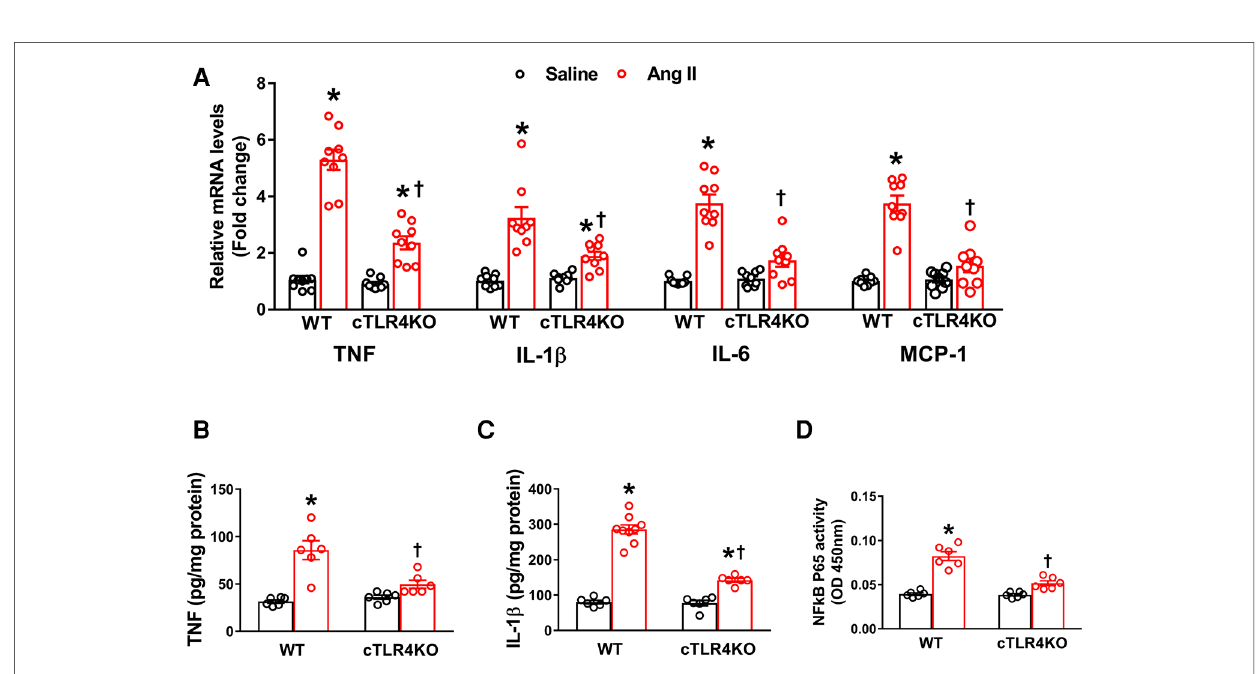
FIGURE 6 Cardiomyocyte-speci fi c TLR4 knockdown reduces mRNA expression of pro-in fl ammatory markers. ( A ) Angiotensin II (Ang II) infusion for 2 weeks signi fi cantly increased TNF, IL-1 β , IL-6, and MCP-1 mRNA expression in the left ventricle cardiac tissue indicating an increased in fl ammatory state. This effect was attenuated in cTLR4KO mice ( n =9, two-way ANOVA, * p <0.05 vs. WT+Saline, † p <0.05 vs. WT+Ang II). ELISA analysis of left ventricular lysates showed that Ang II increased ( B ) TNF and ( C ) IL-1 β in WT mice but these increases were blunted in cTLR4KO mice ( n =6 – 9, two- way ANOVA, * p <0.05 vs. WT+Saline, † p <0.05 vs. WT+Ang II). ( D ) NF- κ B binding activity measured in the left ventricle nuclear extracts exhibited a signi fi cantly increased cardiac NF- κ B p65 activity in WT mice but not in cTLR4KO mice with Ang II-infusion ( n =6, two-way ANOVA, * p <0.05 vs. WT +Saline, † p <0.05 vs. WT+Ang